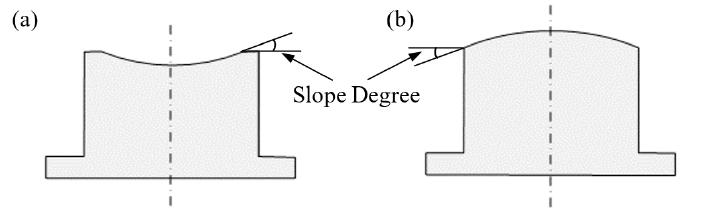
Figure 4. Diagram of the spherical moulds: ( a ) concave and ( b ) convex.